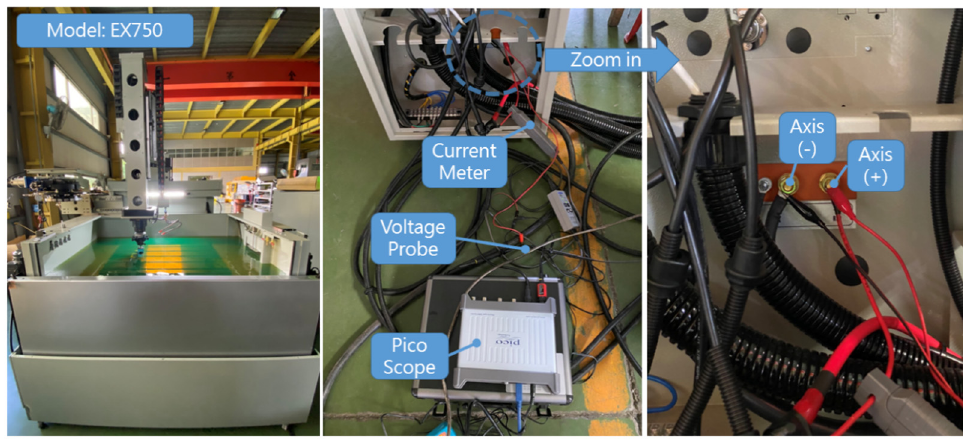
Figure 10. EDM Machine and sensing configuration.